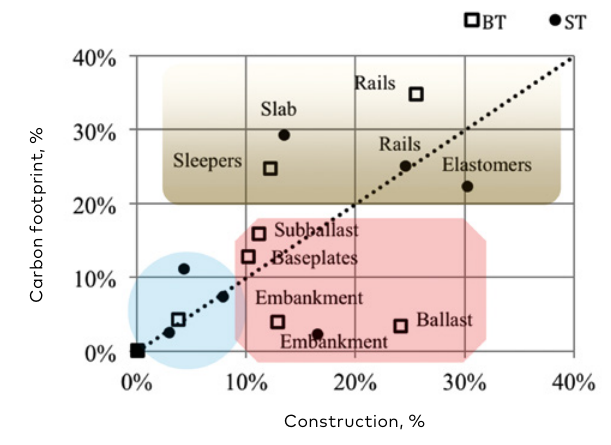
Figure 3. Construction versus carbon footprint